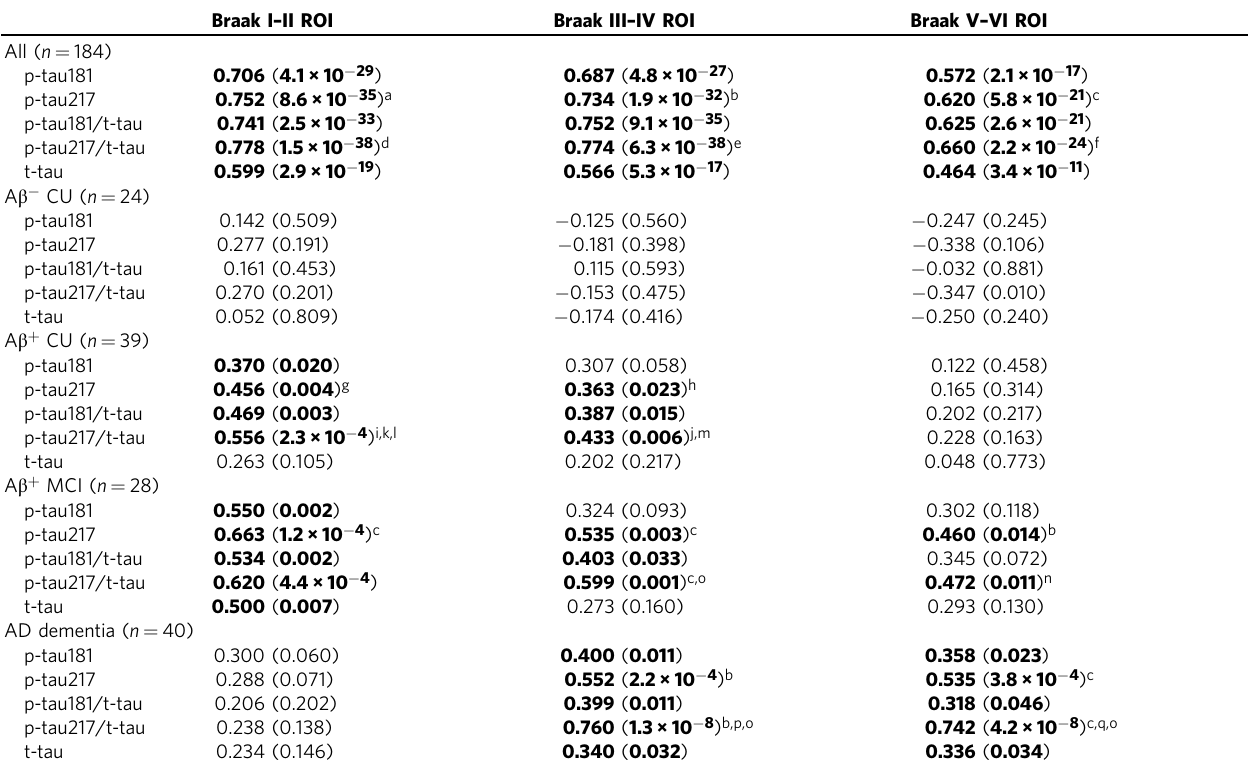
Table 2 Spearman correlations between CSF tau variants and regional [ 18 F] fl ortaucipir retention. Braak I – II ROI Braak III – IV ROI Braak V – VI